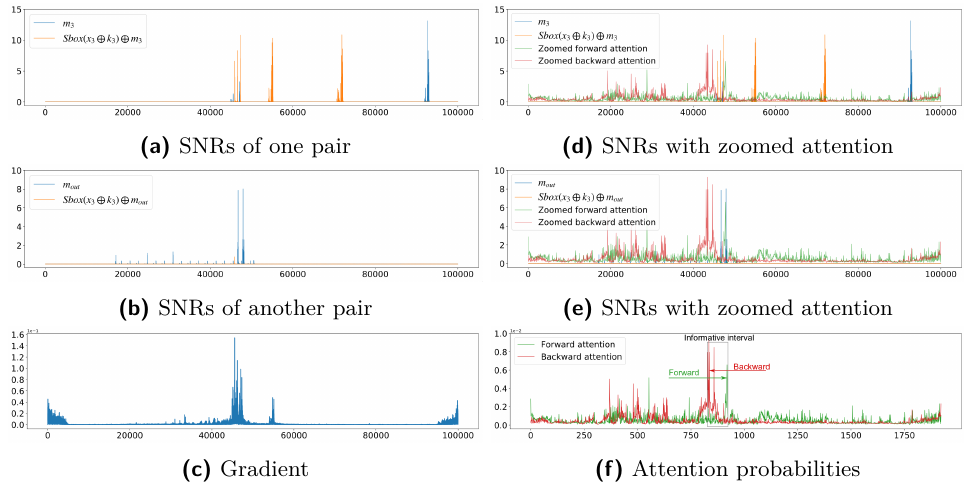
Figure 19: Results of SNRs, gradient and attention for a network trained on ASCAD